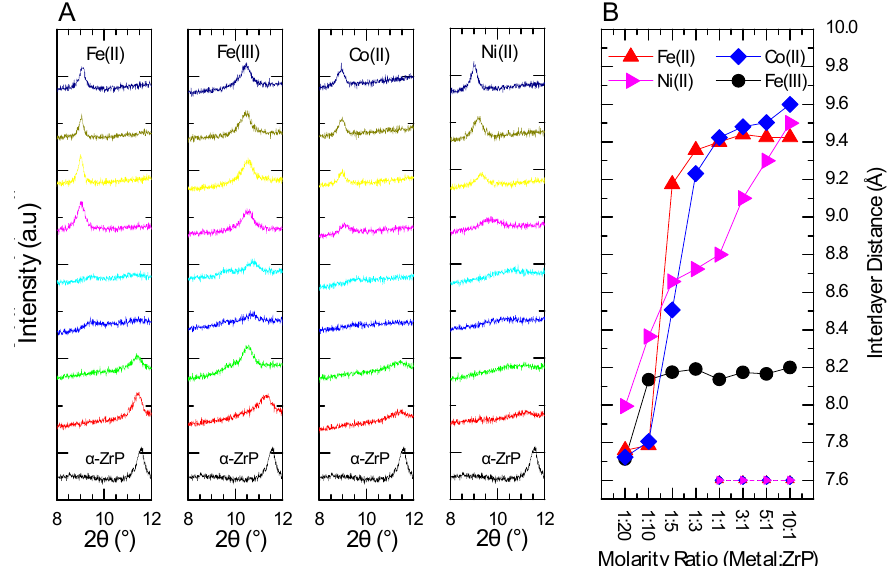
Figure 4. ( A ) XRPD patterns for Fe(II), Fe(III), Co(II), and Ni(II) ‐ intercalated ZrP at (from top to bottom) 10:1, 5:1, 3:1, 1:1, 1:3, 1:5, 1:10, and 1:20 M:ZrP molar ratios. The bottom diffraction pattern in all frames is that of pure α‐ ZrP. ( B ) Interlayer distance as a function of M:ZrP molar ratio for the various metal ‐ intercalated ZrP materials. Metal ‐ adsorbed systems are represented as dashed lines which have an exact interlayer spacing as pure α‐ ZrP indicating that metal intercalation did not occur.